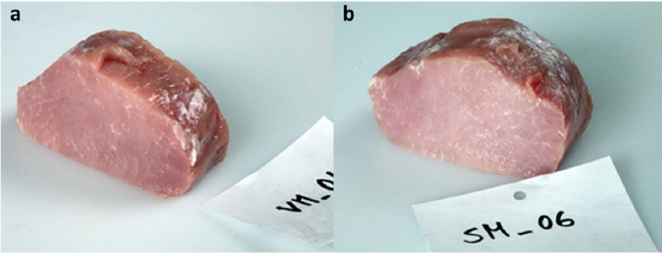
Fig. 2. Muscle tissue cut by the robot armed with (a) the vibrating knife and (b) the Smart